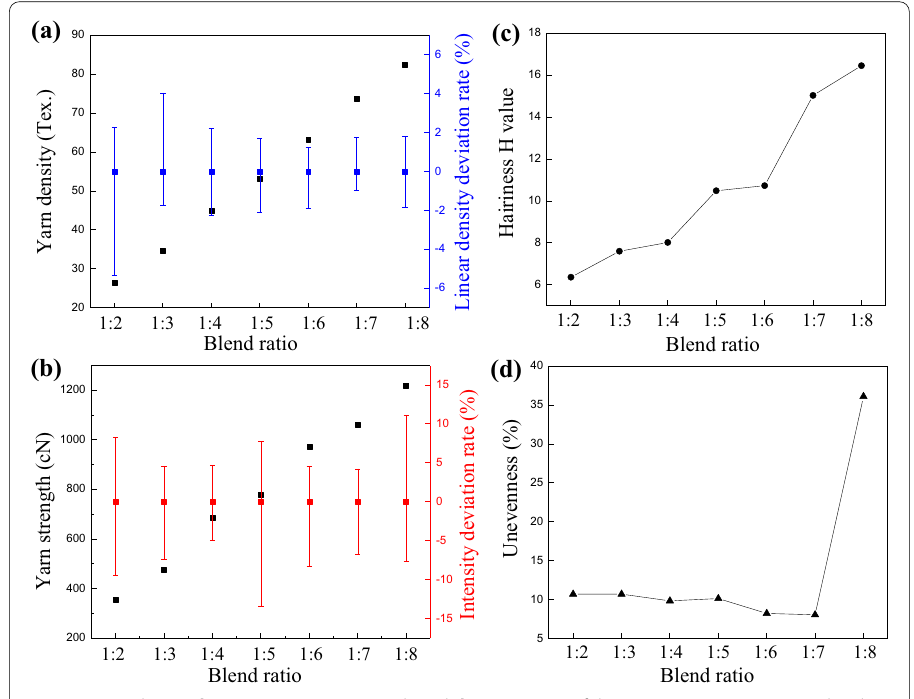
Fig. 4 a Yarn density, b Hairiness, c Yarn strength and d Unevenness of the composite yarns prepared with different blend